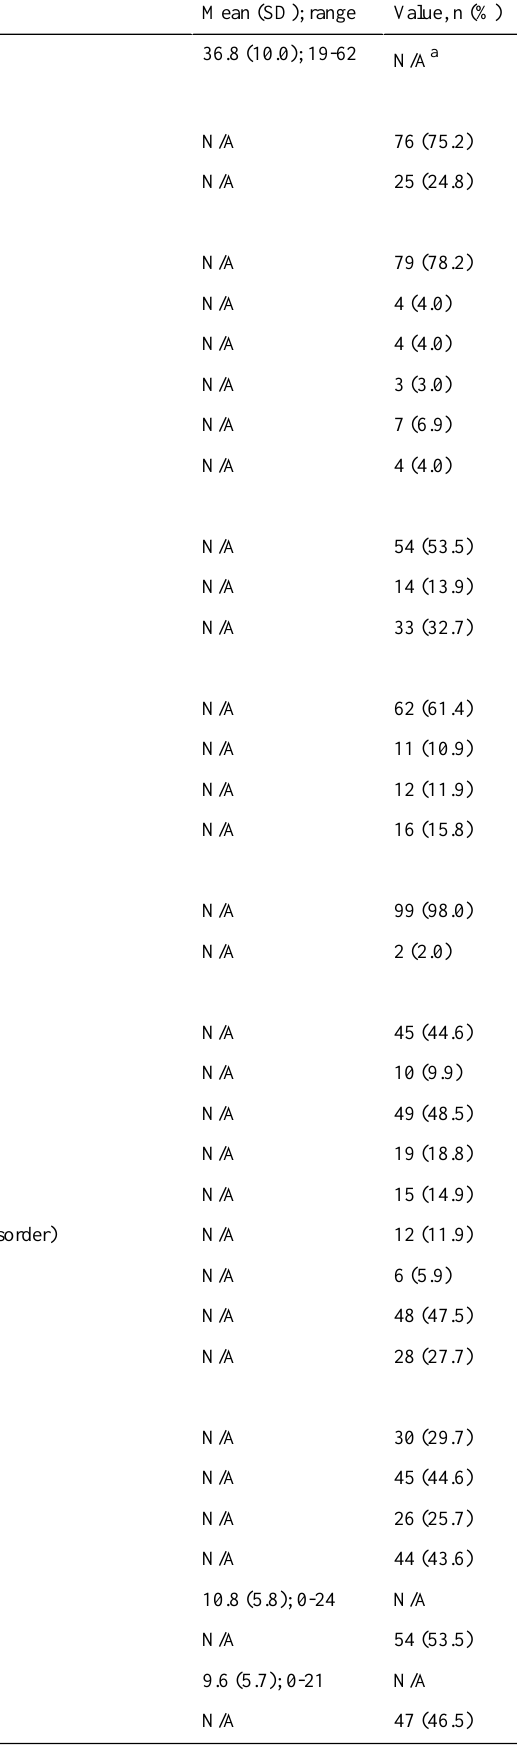
Table 1. Sample characteristics at baseline